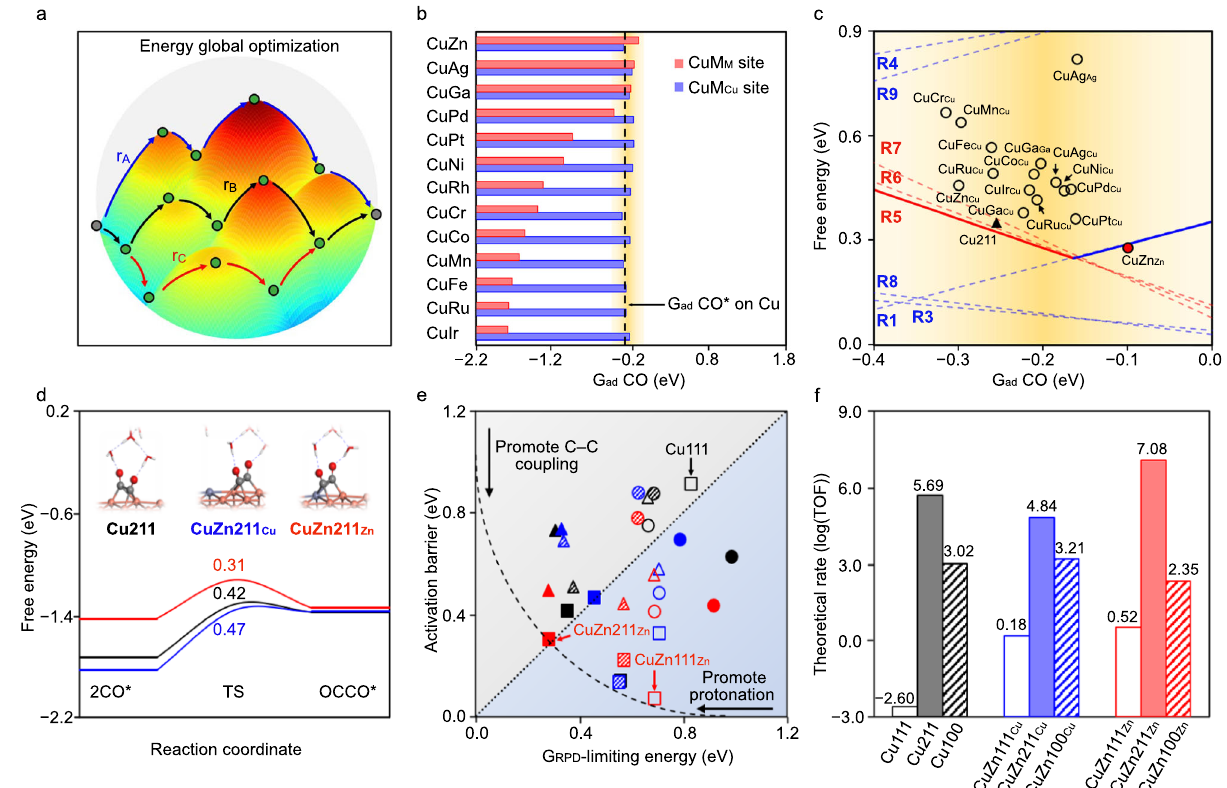
Fig. 1 | Computationalstudies to identifytheoptimalpath for electrochemical C – Ccouplingonbinarysites.a Energy-global-optimisationscheme.Thered,blue, and black paths show different reaction channels, where r A , r B , r C refer to the limitingstepinrelevantpaths(SupplementaryFig.5). b ScreeningofCOadsorption energiesonCu-basedbinaryactivesites.CuM Cu andCuM M refertothebridgesites fortheadsorbate bindingbetweentwo Cuatoms,andCuand Matoms,whereMis the fi rst neighbour atom of Cu (Supplementary Fig. 4). The yellow band shows the expected promising activities. c Reaction phase diagram for CO 2 R to C 2+ at − 0.6 V RHE . The dashed lines (red: C – C coupling steps, blue: protonation steps) indicate the reaction free energies for all considered elementary steps. The solid lines indicatetheG RPD -limitingstepsandenergies.Thepoints(triangleandcircles)show the limiting energies calculated as the maximum of the reaction energy of R1 and